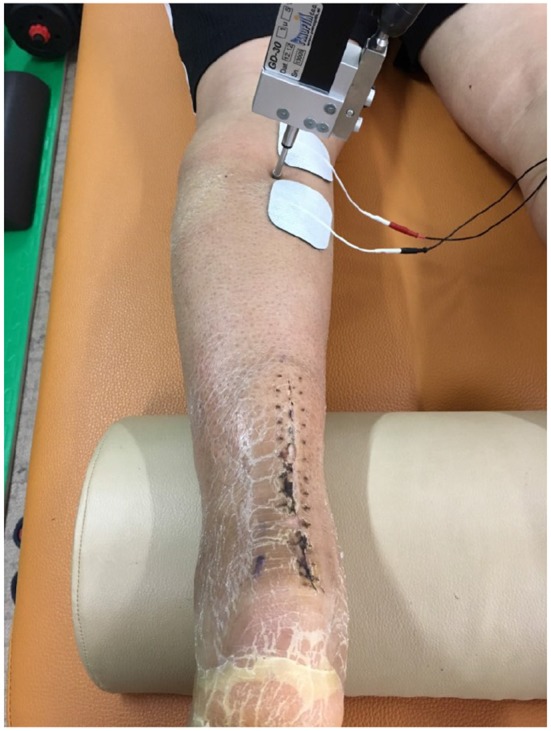
TMG measurement.